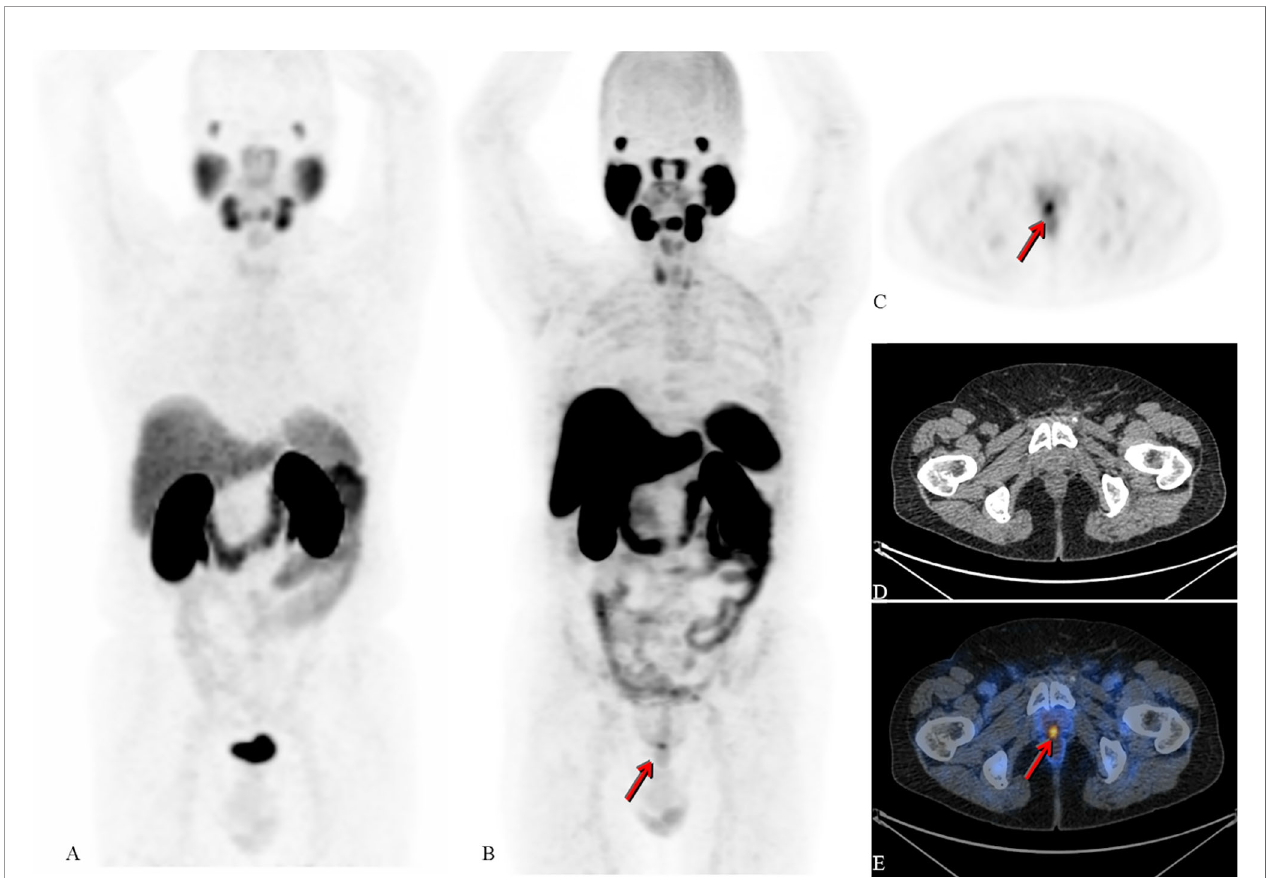
FIGURE 2 | Radical prostatectomy in 2004 due to adenocarcinoma. Salvage radiotherapy due to biochemical recurrence in 2007 with negative restaging on conventional imaging. In 2013, new PSA rise without lesions on restaging with CT, MRI and bone scintigraphy; intermittent androgen-deprivation therapy. Patient referred for 68Ga-PSMA-11 PET/CT in 2016 (not available) and 2017 (maximum intensity projection (MIP); (A) negative for PSMA-expressing lesions (PSA levels at 0.8 and 1.0ng/mL, respectively). Due to further increase of PSA (1.1ng/mL) an 18F-PSMA-1007 PET/CT examination took place in 2018. Images B - E show 18F- PSMA -1007 PET/CT of the same patient (B) : MIP, (C) : axial cross section PET, (D) : axial cross section CT, (E) : fused axial PET/CT image). Arrows show unequivocal PSMA-expression corresponding to local recurrence; the quality of the image is not biased by PSMA-detection in the ureters or inside the bladder (in comparison to A ) [republished with permission of the Hellenic Journal of Nuclear Medicine